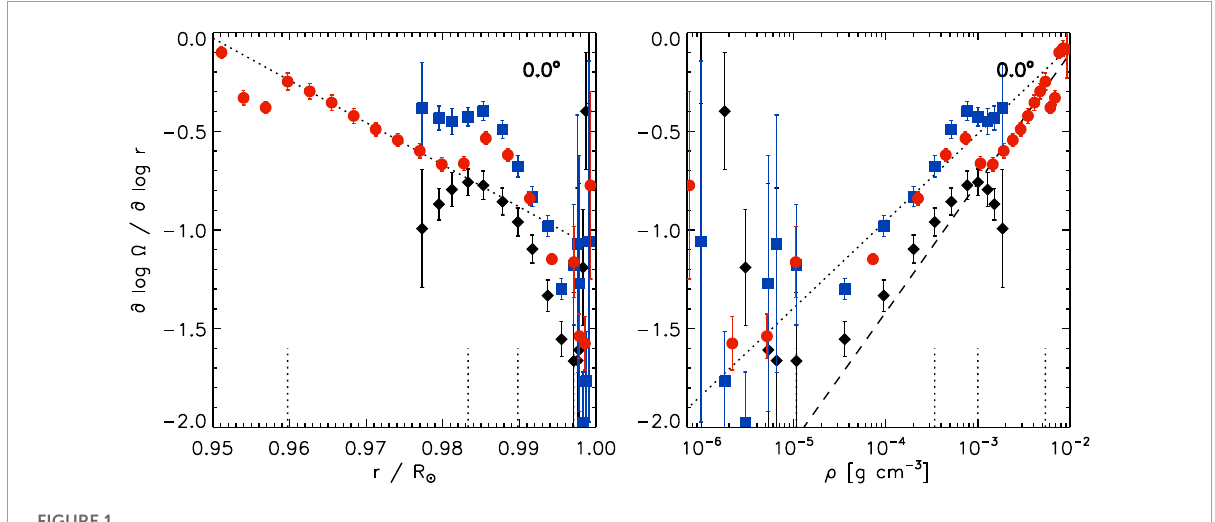
FIGURE 1 The radial gradient of the solar rotation rate as a function of radius (left) and density (right) using 15°-tile RDA (black diamonds: GONG, blue squares: HMI) and 30°-tile RDA (red circles: HMI) at the equator averaged over Solar Cycle 24. The dotted and dashed lines indicate linear and log-linear regressions, as described in the text. The short vertical dotted lines indicate four depths (.960 R ⊙ , .983 R ⊙ , .990 R ⊙ , and .997 R ⊙ ).